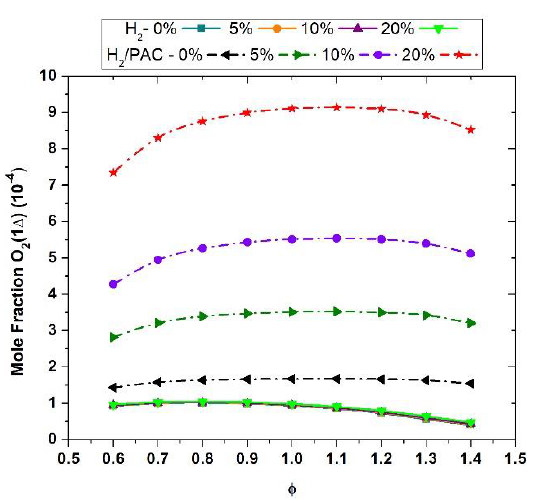
Figure 7. Comparative behavior of flame speed improvements (%) at lean, stoichiometric, and rich conditions.